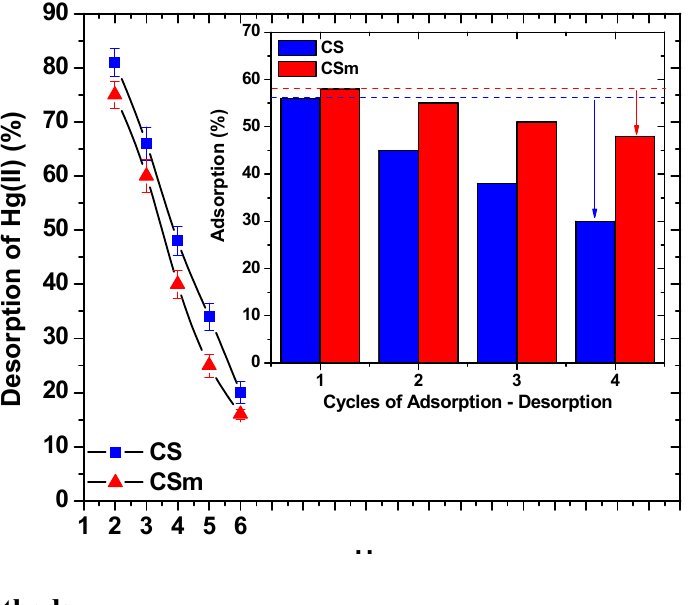
Figure 11. Effect of pH on the desorption of Hg(II) from CS and CSm (inset: cycles of